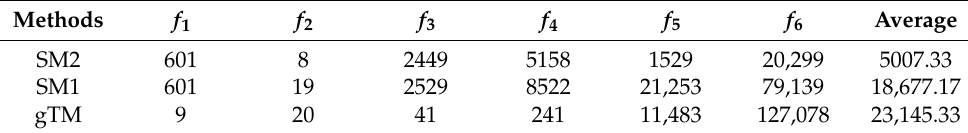
Table 3. Number of divergent points (DP) for each method on the test